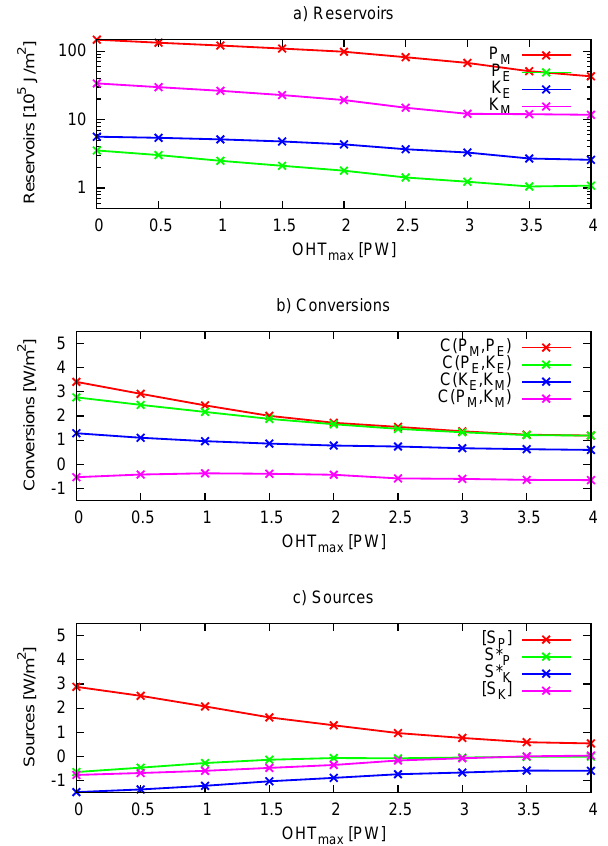
Figure 19. Climatological mean Lorenz energy cycle: reservoirs (upper panel, in 10 5 Jm − 2 ), conversions (middle panel, in Wm − 2 ) and sources (lower panel, in Wm − 2 ) for all simulations.